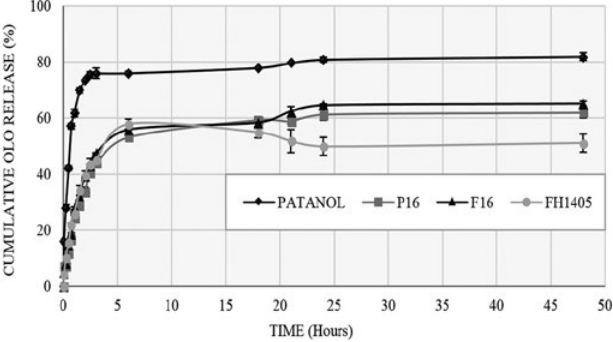
FIGURE 7 - Concentration-time profiles of OLO after administration of in situ gel formulations and Patanol